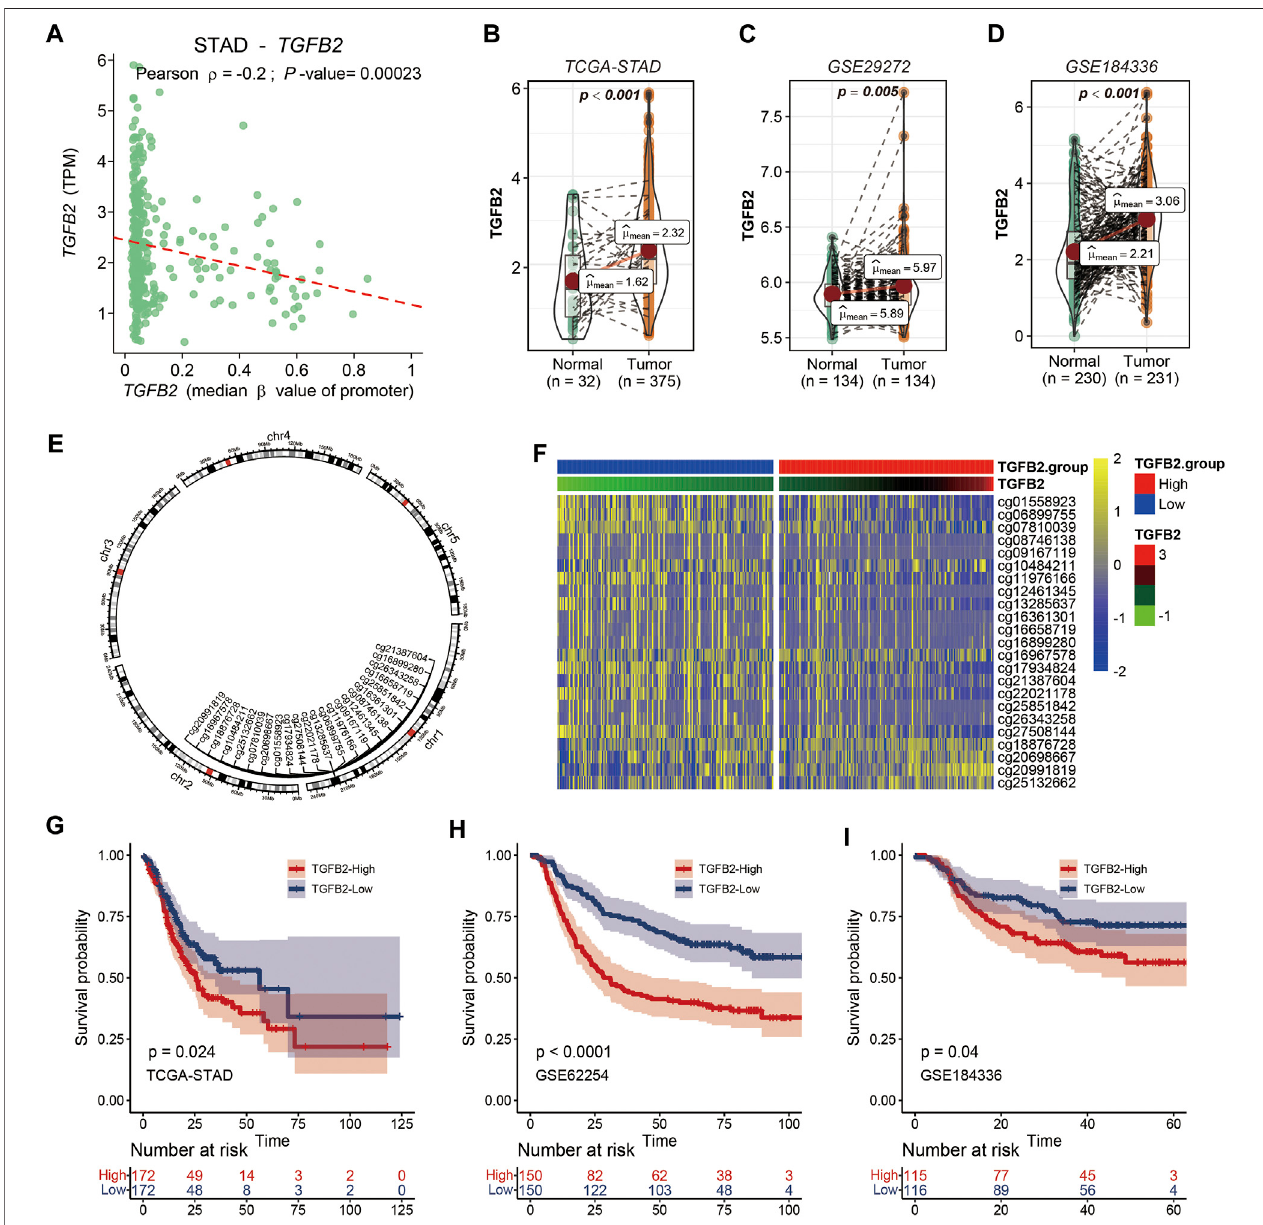
FIGURE 1 | TGF β 2 and TGF β 2 Methylation. (A) Relationship between TGF β 2 and TGF β 2 methylation promoter region. (B – D) TGF β 2 expression in gastric cancer tissuesandnormaltissues inSTAD,GSE29272andGSE184336 (HMUCH). (E) LocationoftheTGF β 2methylationsiteonthechromosome. (F) HeatmapofTGF β 2and TGF β 2 methylation expression. Kaplan-Meier survival analysis of TGF β 2 in STAD (G) , GSE62254 (H) and GSE184336 (I)